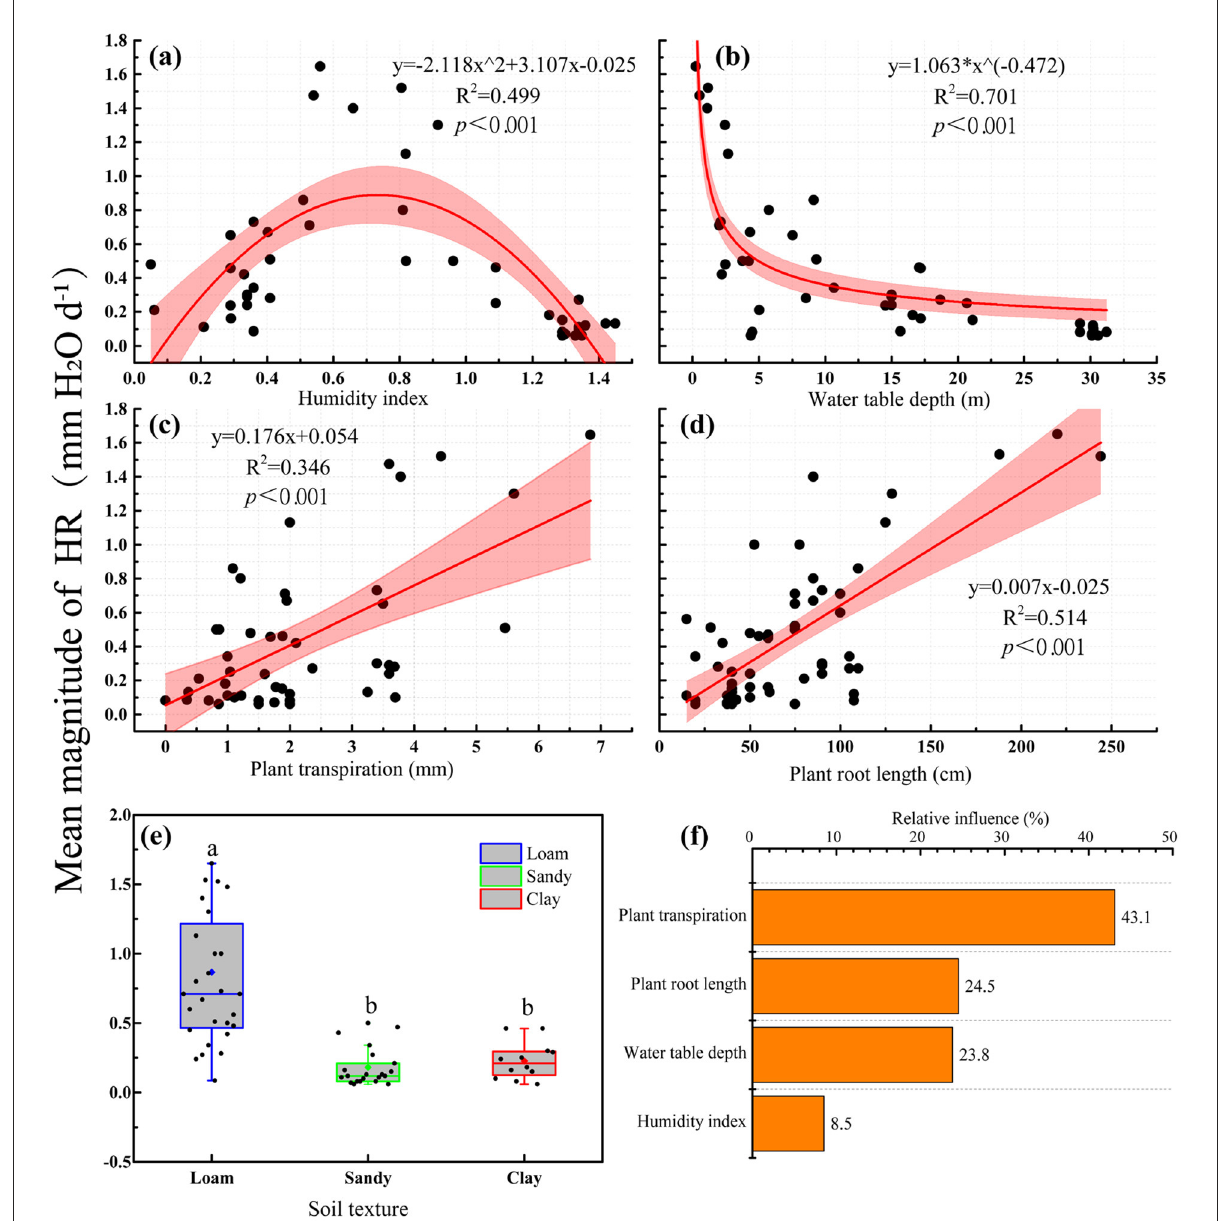
FIGURE4 The factors influencing HR. Relationship between HR and environmental factors (a–d) ; (e) influence of soil texture on HR. The boxplots characterize the lower, median, upper quartiles, and the interquartile range (upper quartile–lower quartile), which covers the central 50% of the data. The whiskers represent 95% of the data. The diamond within each boxplot represents the mean and each small circle represents one individual observation. (f) Relative percentages of the influence of vegetation characteristics and environmental factors on HR magnitude. Different lowercase letters indicate significant difference at the 0.05